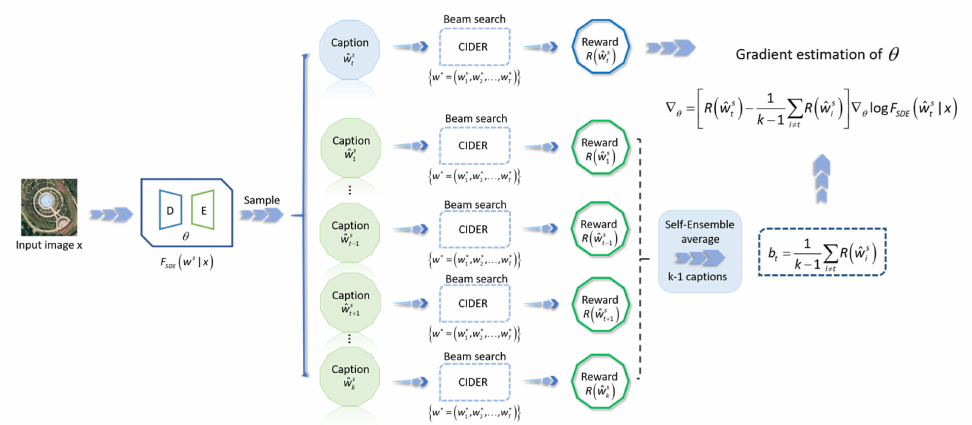
Figure 4. Schematic diagram of our proposed process for optimizing model parameters using self- critical. A remote sensing image x is input to the model F SDE ( x ) trained by self-ensemble and self-distillation, and K mutually independent captions ˆ w s , ˆ w s , . . . , ˆ w s are sampled. We average the 2 1 k CIDEr scores of the k – 1 captions except ˆ w s to obtain the baseline for the self-critical training of t caption ˆ w s . The CIDEr scores of the descriptions are computed by beam search. Self-critical uses the t baseline obtained from this self-ensemble to compute the gradient estimation of the parameters θ of model F SDE ( x )